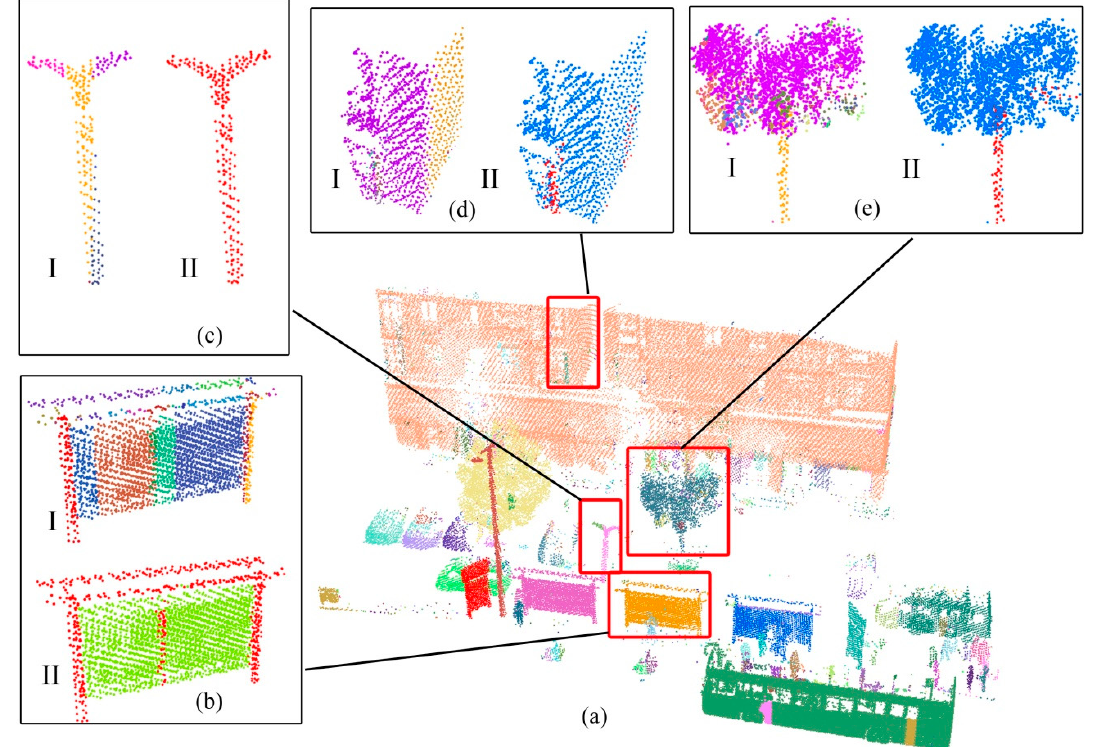
Figure 6. Category-oriented merging. ( a ) Merging results, points of the same color belong to the same segment; ( b – e ) I: Single real-world object with several voxel groups, points of the same color belong to the same voxel group; II: Shapes of one object, red denotes linear points, green denotes surface points, and blue denotes spherical points.